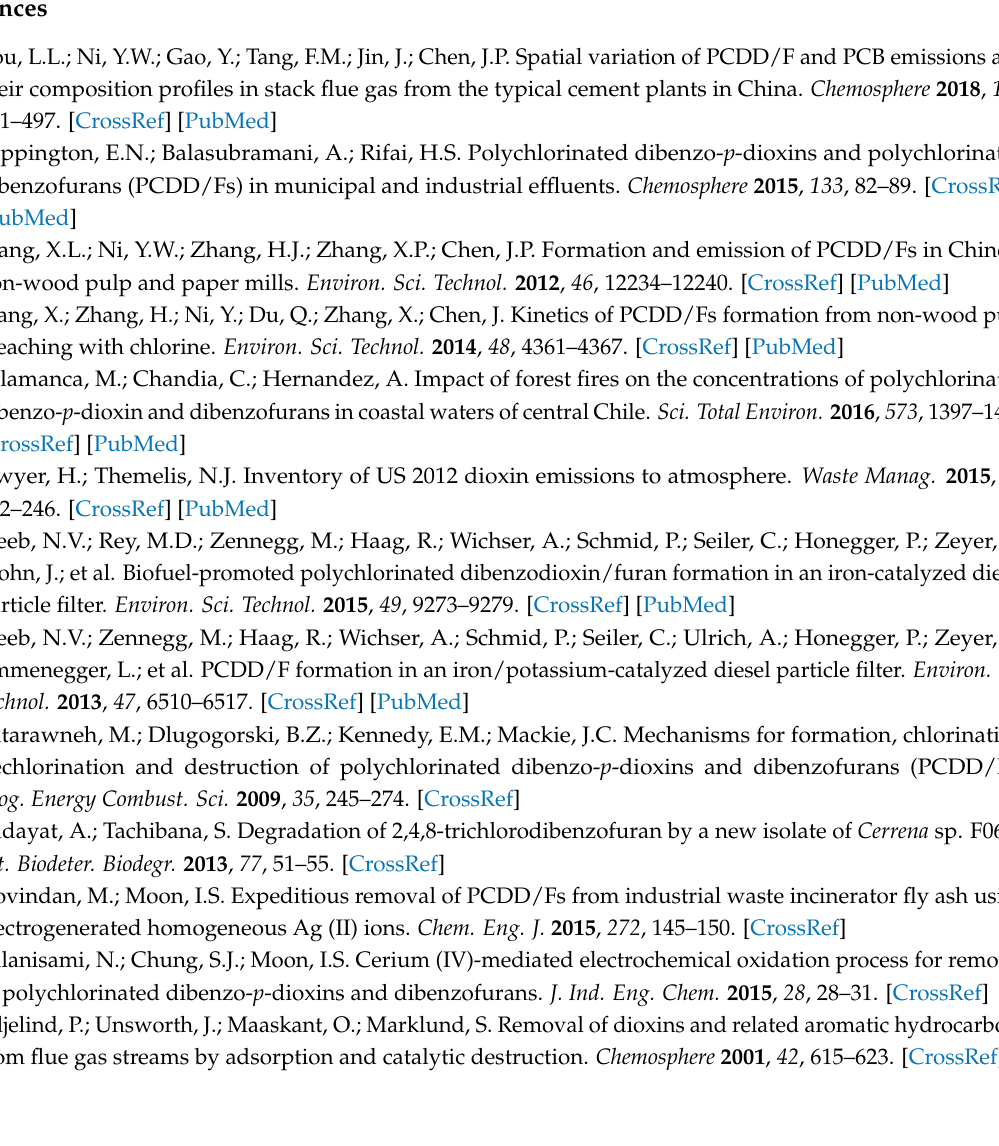
Supplementary Materials: The following are available online. Figure S1: Molecular graphs of the intermediates (IM) and transition states (TS) in the different reaction pathways involving neutral H 2 O 2 . Table S1: Topological parameters for the intermediates in the different reaction pathways involving neutral H 2 O 2 . Table S2: Cartesian coordinates of the optimized species in the present study. Table S3: Calculated energy parameters for the optimized species in the present